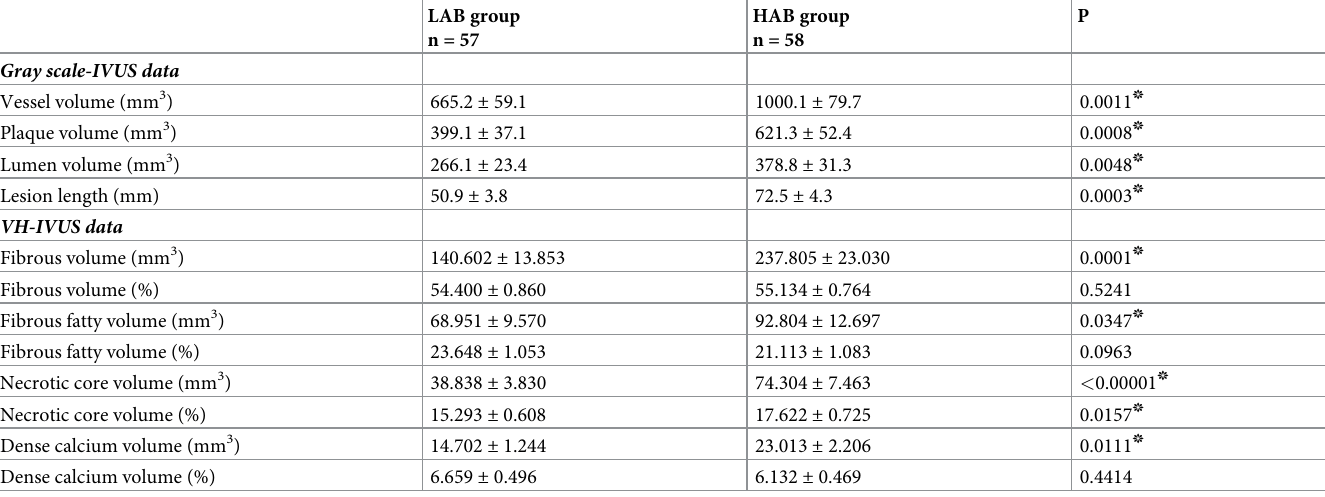
Table 2. Gray scale- and VH-IVUS data in patients with low and high plasma apolipoprotein B.